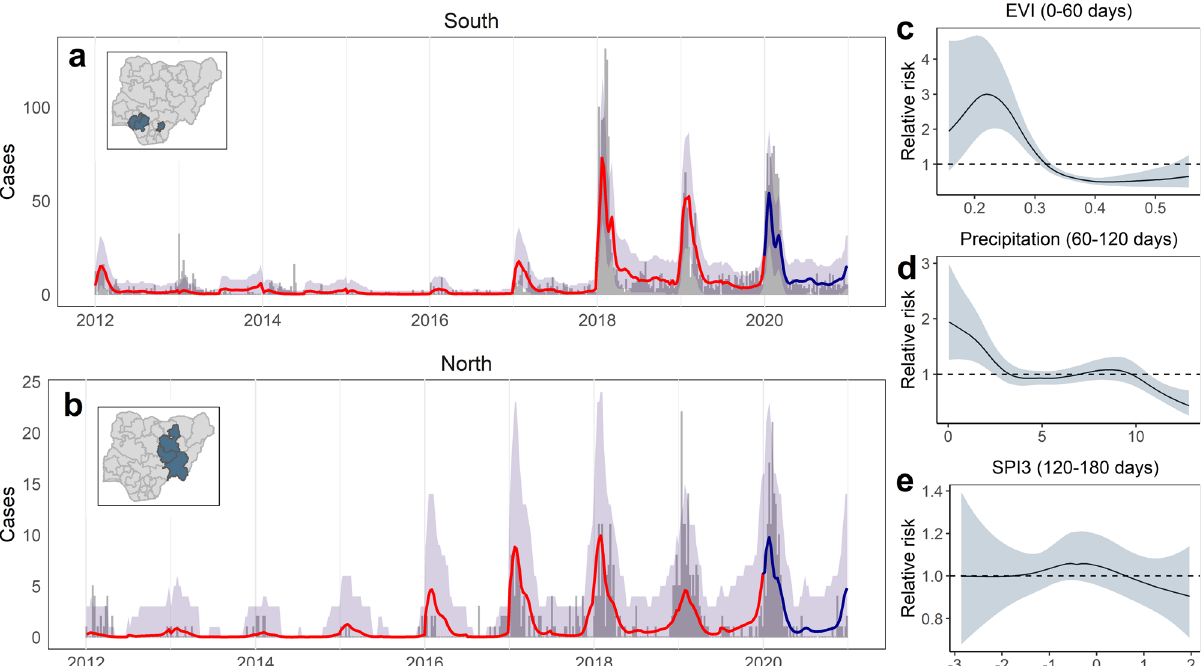
Fig. 4 Modelled temporal dynamics and drivers of con fi rmed Lassa fever cases in the south and north Nigeria. Case time series show observed and out- of-sample (OOS) predicted weekly case counts from a climate-driven model ( n = 2820), summed across all states in the southern ( a ; Edo and Ondo states) and northern ( b ; Bauchi, Plateau and Taraba states) endemic areas to visualise regional differences. Time series graphs ( a , b ) show observed counts from 2012 to 2019 (grey bars), OOS posterior median predicted cases (red line) and OOS 95% (grey shading) posterior predictive intervals (both calculated from 2500 samples drawn from the joint posterior). OOS predictions were made while holding out sequential 6-month windows across the full time series at state-level (Supplementary Fig. 8). The dark blue line and shaded area in 2020 shows prospective predicted cases (median and 95% predictive interval) compared to observed cases from this period, which were not included in model fi tting (Methods). Inset maps show states included in the models. Panels show nonlinear fi tted effects of Enhanced Vegetation Index (EVI) ( c ), mean daily precipitation ( d ), and 3-month Standardised Precipitation Index (SPI3; e ) on relative risk, showing posterior mean and 95% credible interval. The marginal contributions of yearly, seasonal and climatic effects are visualised separately in Supplementary Fig.